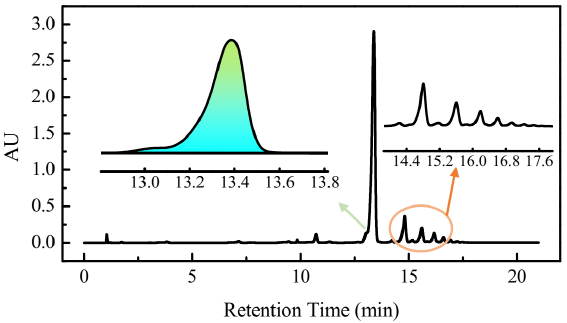
Figure 1. Chromatographic separation of oligomers.